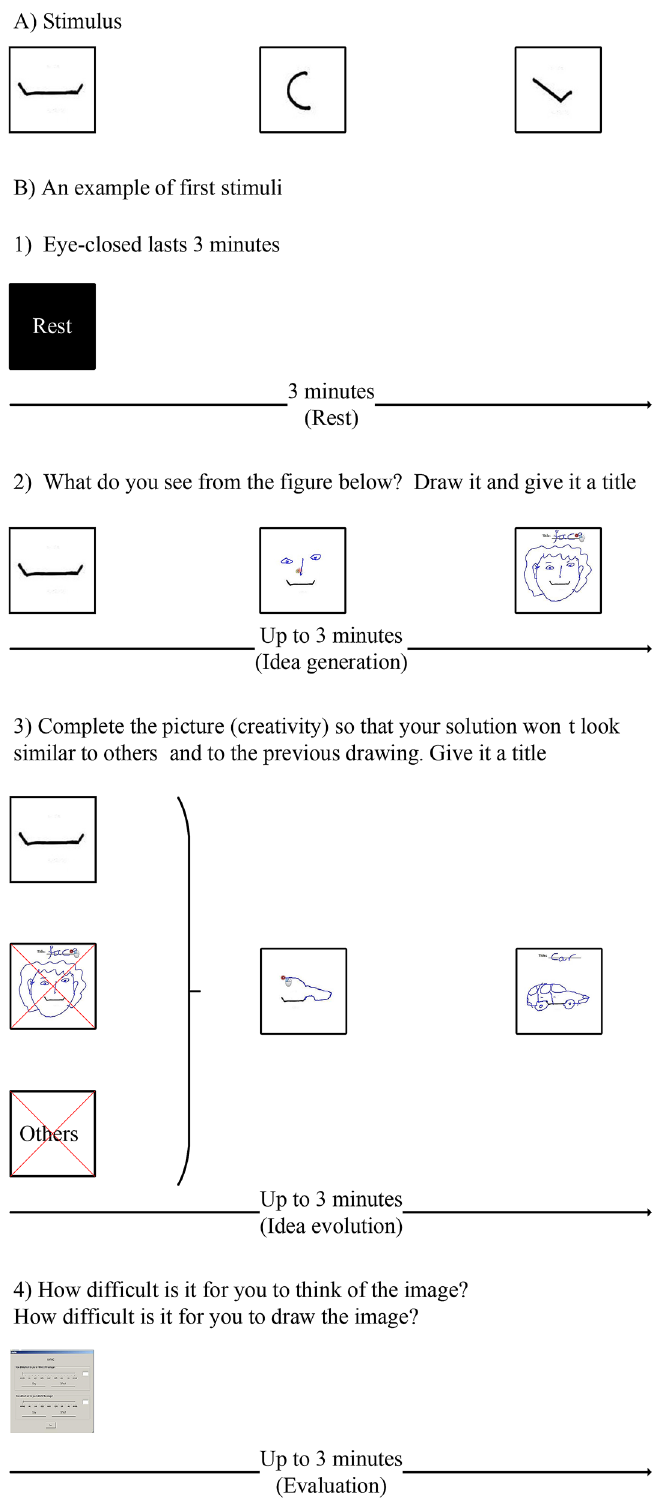
Figure 7. ( A ) Three different stimuli. ( B ) The first stimulus of schematic time courses of the modified TTCT-F. (1) A 3-minute rest period served as the baseline. (2) A maximal 3-minute idea generation period refers to an activation state. (3) A maximal 3-minute idea evolution period refers to an activation state. (4) A maximal 3-min evaluation period served as an activation state and a breaking fixation